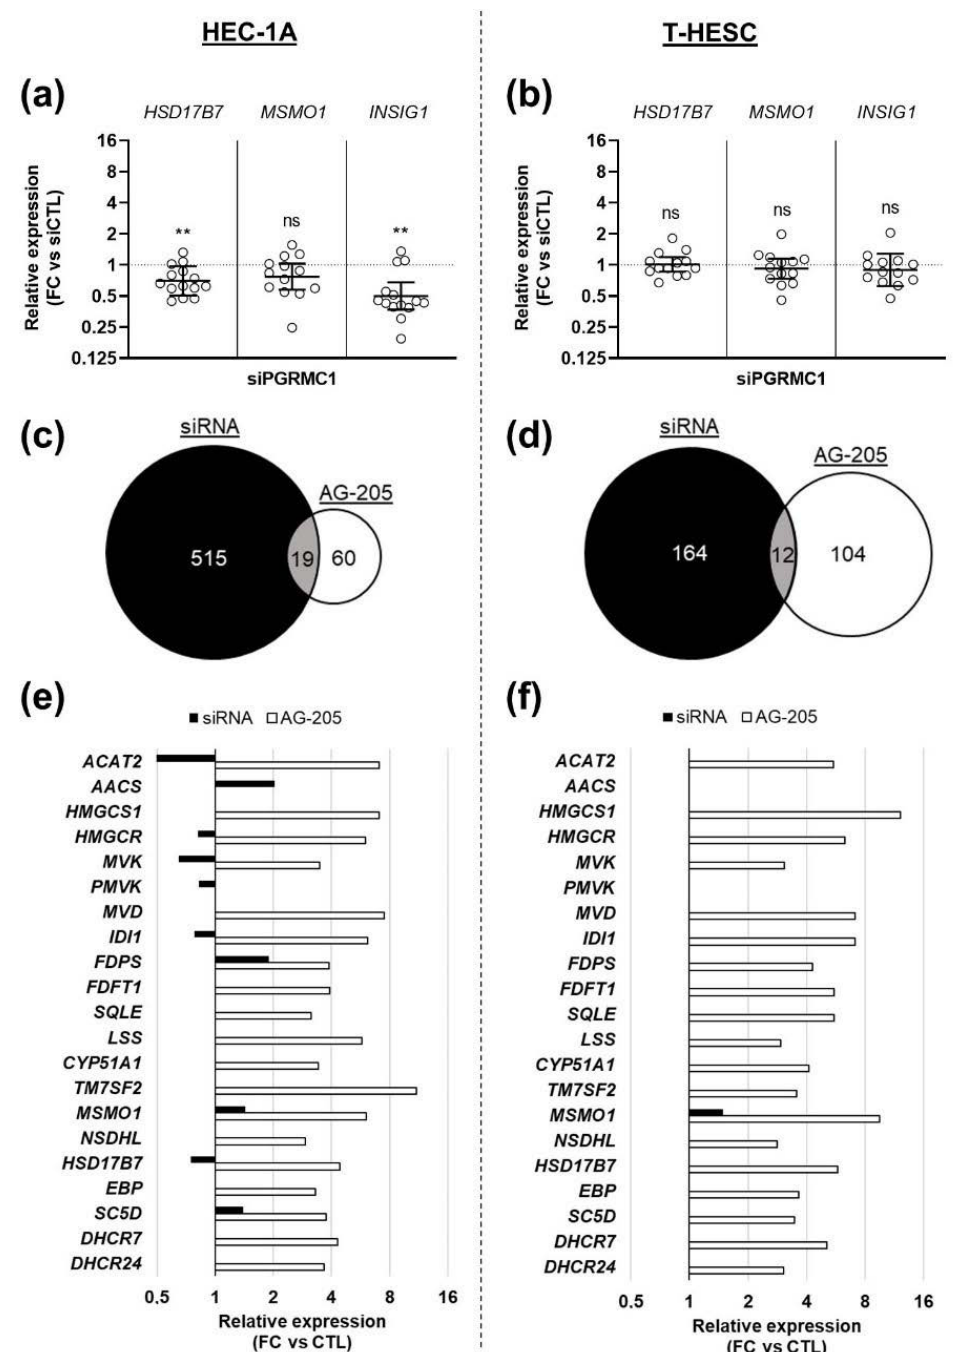
Figure 4. siRNA-mediated down-regulation of PGRMC1 expression does not mimic the effect of AG-205. HEC-1A ( a , c , e ) or T-HESC ( b , d , f ) cells were incubated for 80 h with 10 nM siRNA-PGRMC1 s21310 (siPGRMC1) or control siRNA-CTL (siCTL). ( a , b ) Relative expression of HSD17B7 , MSMO1 and INSIG1 was measured by RT-qPCR ( n = 13–14), normalized, compared to corresponding siCTL values and is presented as individual fold changes (FC) in log2 scale and as geometric means with geometric SD. Statistical test: Wilcoxon paired test, not significant (ns), ** p < 0.01. ( c , d ) Transcriptomes of siPGRMC1 and siCTL-transfected cells were established by RNA sequencing ( n = 3) and analyzed by over-representation analysis (ORA). Results were compared with those previously obtained with AG-205 addition. Figures present the number of GO terms differentially expressed upon siPGRMC1 transfection (in black), AG-205 addition (in white) and in common (in grey). ( e , f ) The effect of siPGRMC1 (in black) on expression of genes represented in Figure 2c is compared to the effect of AG-205 (in white), with values retrieved from Figure 2c for direct visual comparison. Expression variations measured by comparison with corresponding control (siCTL or DMSO) are indicated as fold changes